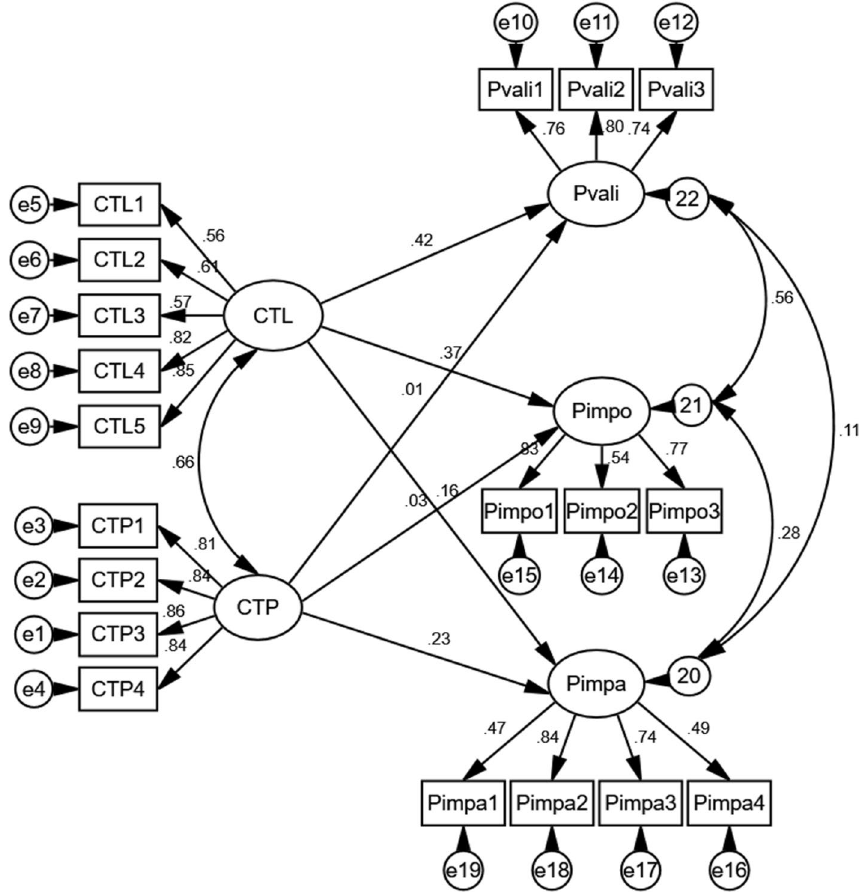
Fig. 1 Structural model with standardized parameters